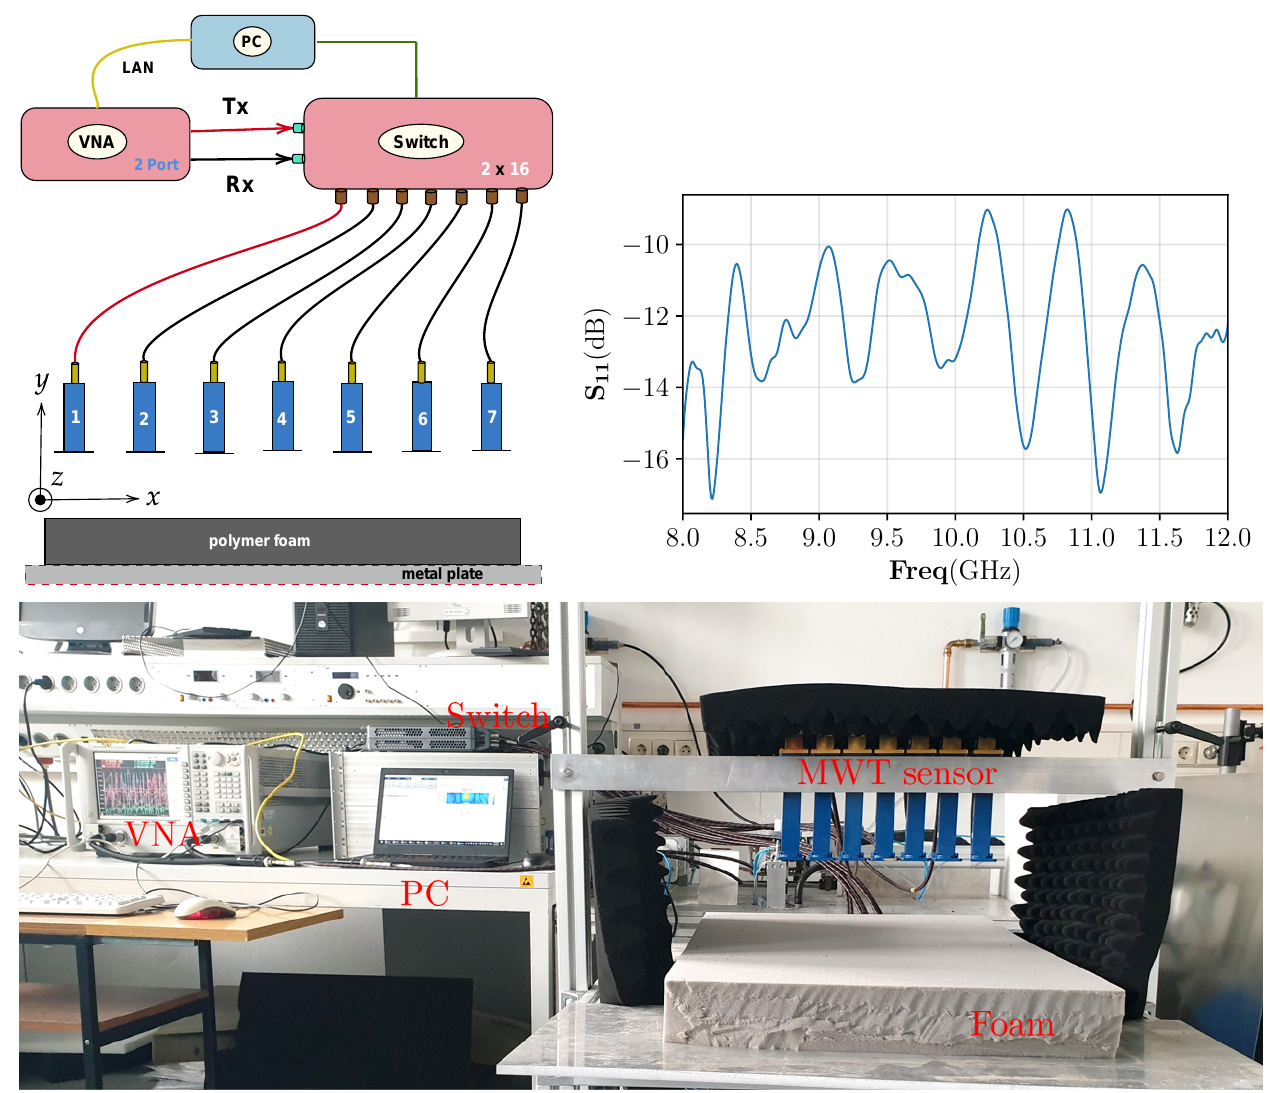
Figure 8. Top left : data acquisition scheme for the MWT measurement from the sensor array with X-band open waveguide antennas. Top right : the S 11 response of the WR-90 waveguide antenna. Bottom : prototype of MWT sensor array used in this study to generate measurement data. This system is developed at KIT, Germany and has been integrated with the HEPHASITOS technology.